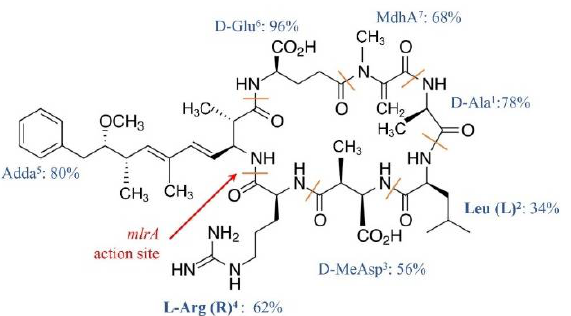
Figure 1. Chemical structure of hepatotoxic microcystin-LR. Numbers 1–7 signify the presence of amino acid residues with their percent of variation. Positions 2 and 4 depict the highly variable L-amino acids. mlrA site of cleavage on the MC-LR cyclic structure has also been depicted. Ala 1 , MeAsp 3 , and Glu 6 were D-amino acids. Adda 5 , or C 20 amino acid (3-amino-9- methoxy-2, 6, 8-trimethyl-10-phenyldeca-4, 6-dienoic acid), and MdhA 7 are